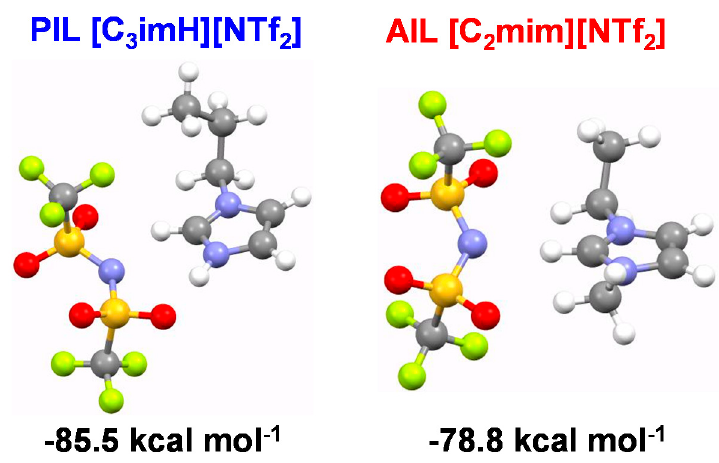
Figure 5. The most stable structures of [C 3 imH][NTf 2 ], and [C 2 mim][NTf 2 ] ion pairs, and their stabilization energies. Geometries were optimized at HF/6-311G** level. Stabilization energies were calculated at MP2/6-311G** level using the optimized geometries. Energy in kcal/mol.